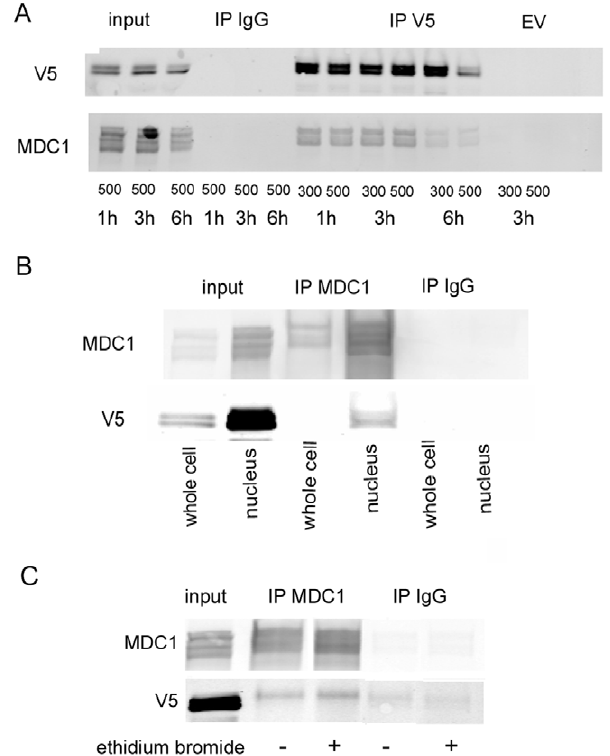
Figure 2. Confirmation by Western analysis of identification of MDC1 in immunoprecipitates of TonEBP/OREBP-1-547-V5. ‘‘Input’’ is the protein extract before immunoprecipitation. A. Osmo- lality bathing HEK 293 cells stably transfected with TonEBP/OREBP-1- 547-V5 or empty vector-V5 (EV) was raised from 300 to 500 mosmol/kg by adding NaCl for 1, 3 and 6 h. Proteins were immunoprecipitated with rabbit IgG or anti-V5 antibodies and immunoblotted with anti-V5 or anti-MDC1 antibody. B . Osmolality bathing HEK 293 cells stably transfected with TonEBP/OREBP-1-547-V5 or empty vector-V5 was raised from 300 to 500 mosmol/kg by adding NaCl for 2 h. Proteins were immunoprecipitated from nuclear lysates with rabbit IgG or anti- MDC1 and immunoblotted with anti-MDC1 or anti-V5 antibody. C . 100 m g/ml ethidium bromide was added during immunoprecipitation with anti-MDC1 from nuclear extracts of the stably transfected HEK293 cells expressing TonEBP/OREBP-1-547-V5.